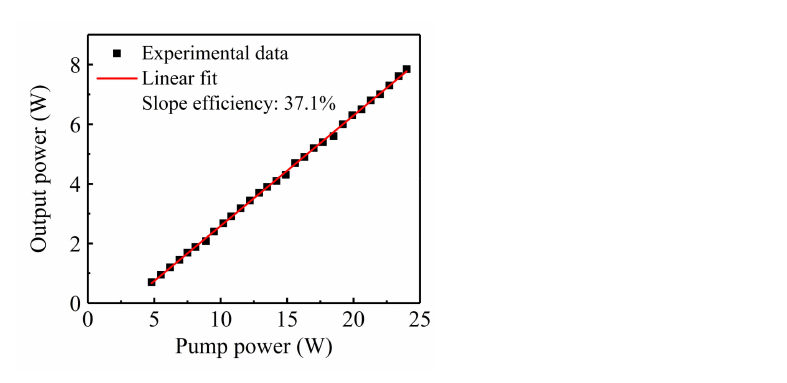
Figure 6. Output power of the pre-amplifier with increasing incident pump power.